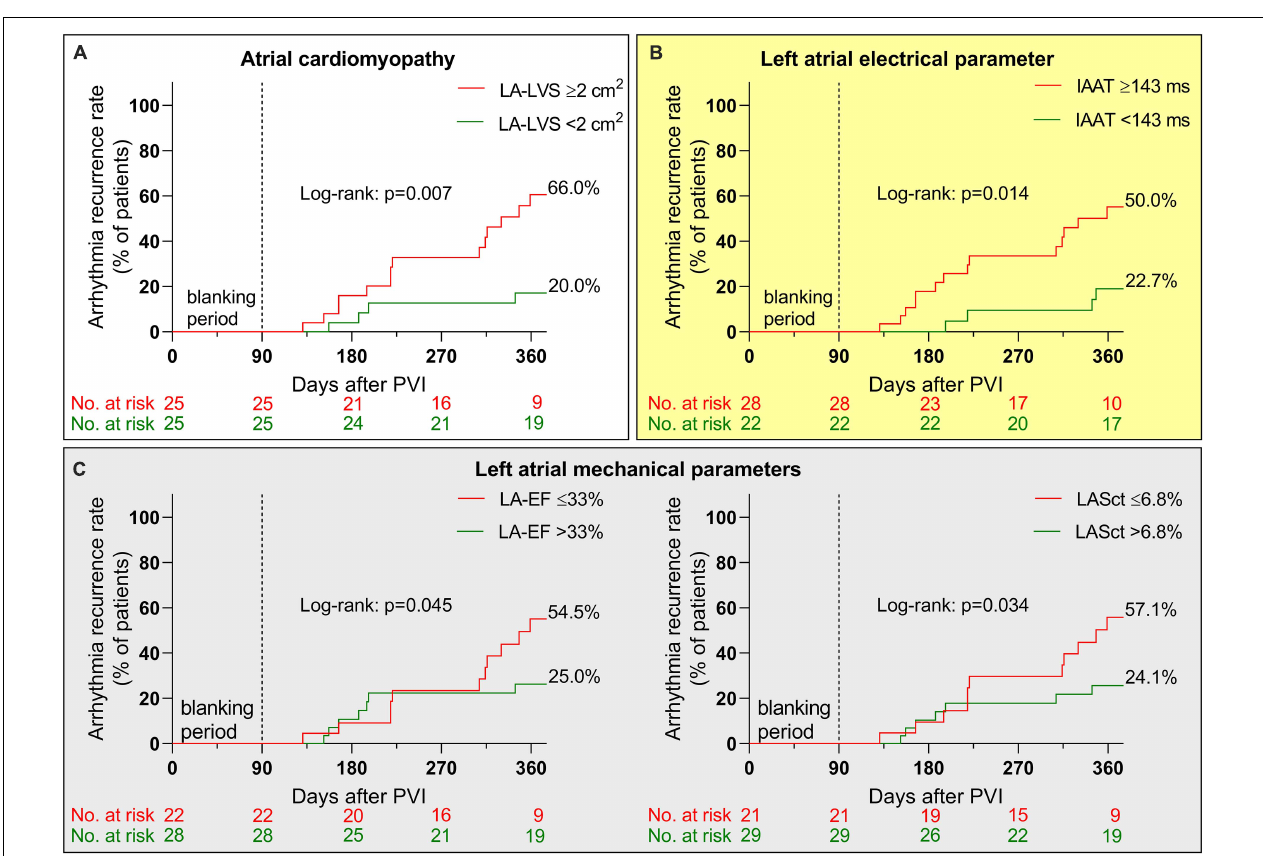
Univariate regression analysis